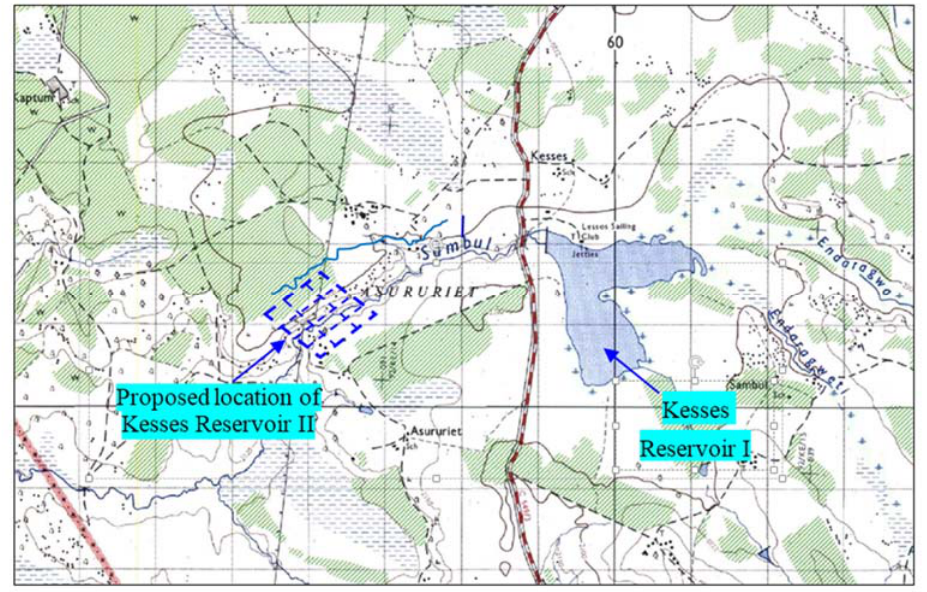
Figure 2. Topographical map of the study site showing the location of the existing Kesses reservoir I and the proposed Kesses reservoir II.